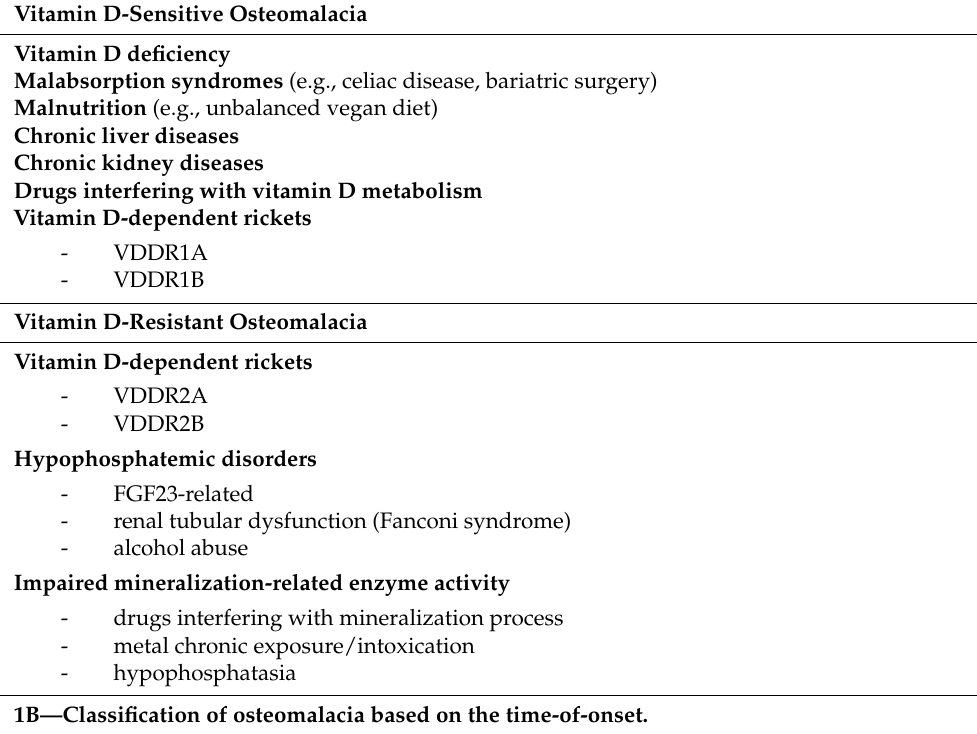
Table 1. Classification of osteomalacia based on: response to treatment with vitamin D metabo- lites (1A), time-of-onset (1B), and pathogenesis